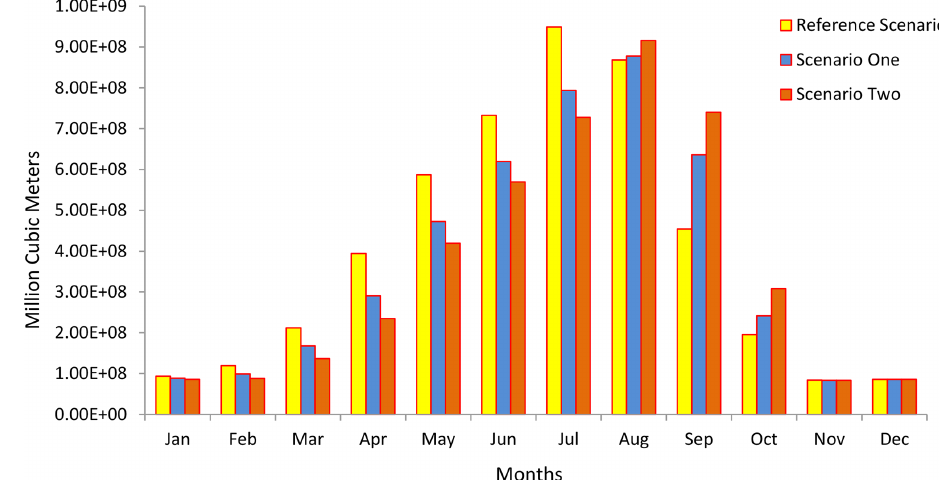
Figure 6. Simulated inflow (mcm) under current and future climate change for all scenarios.